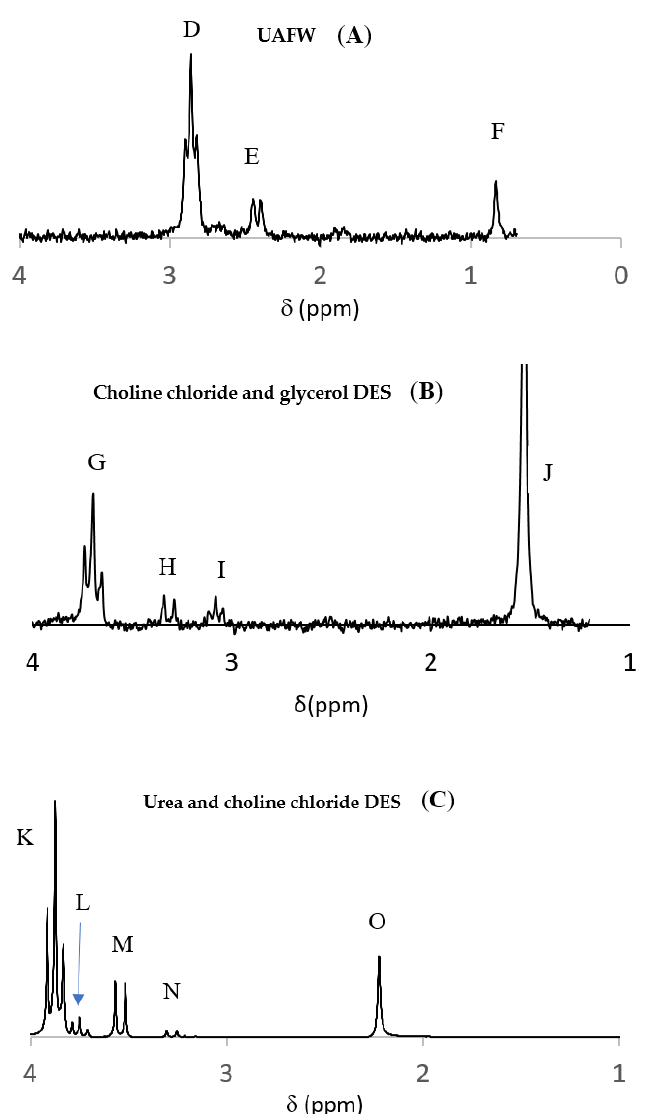
Figure 10. 31 P-NMR spectra of glycerol phosphorylation reactions carried out in various non-aqueous solvents: ( A ) UAFW, ( B ) choline chloride and glycerol DES, ( C ) urea and choline chloride DES. The slight shift in the PPM value of the triplet is attributed to the pH changes present in the various solvents. (C) was reprinted and reused with permission from [137]; Copyright © 2017 Elsevier.